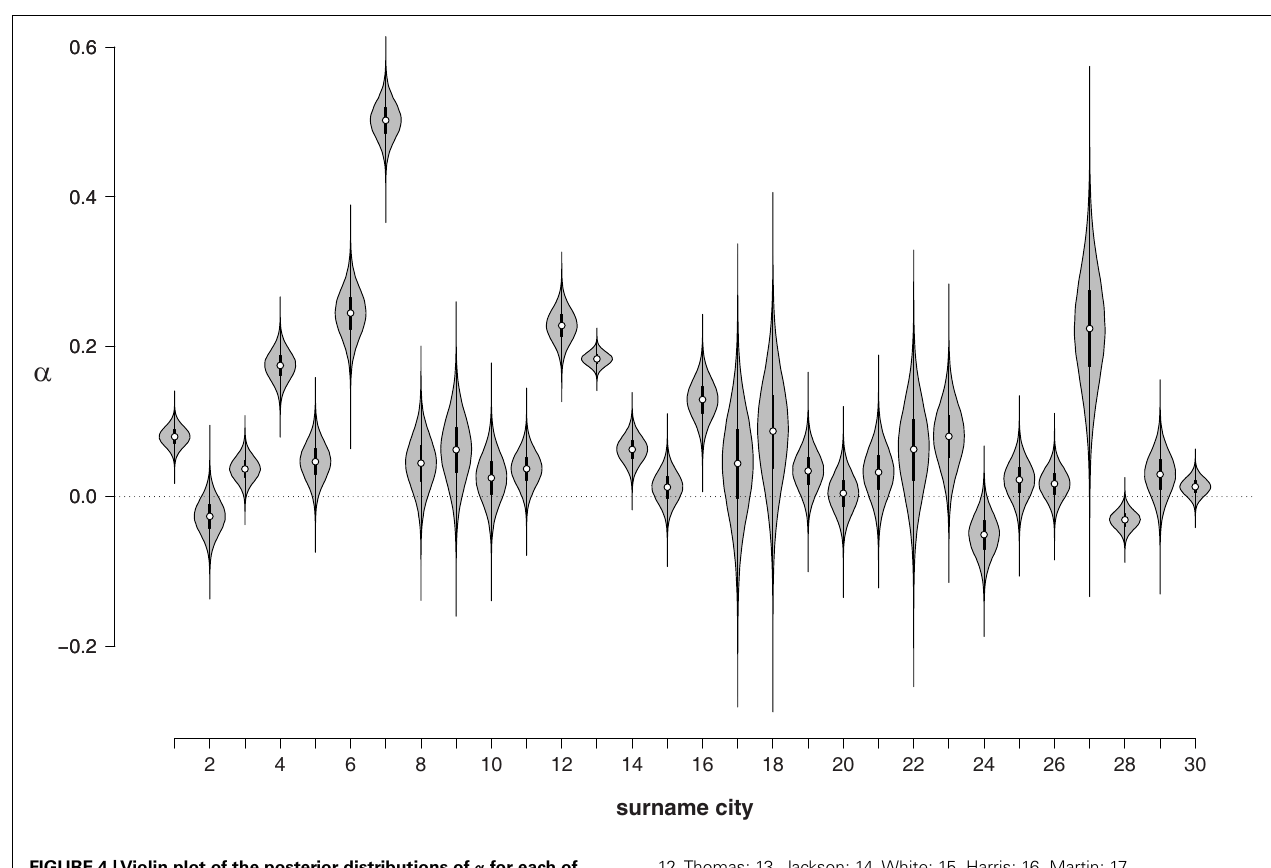
FIGURE 4 |Violin plot of the posterior distributions of α for each of the surname cities. Note that the distributions do not integrate to 1 in this representation. 1, Smith; 2, Johnson; 3,Williams; 4, Jones; 5, Brown; 6, Davis; 7, Miller; 8,Wilson; 9, Moore; 10,Taylor; 11,